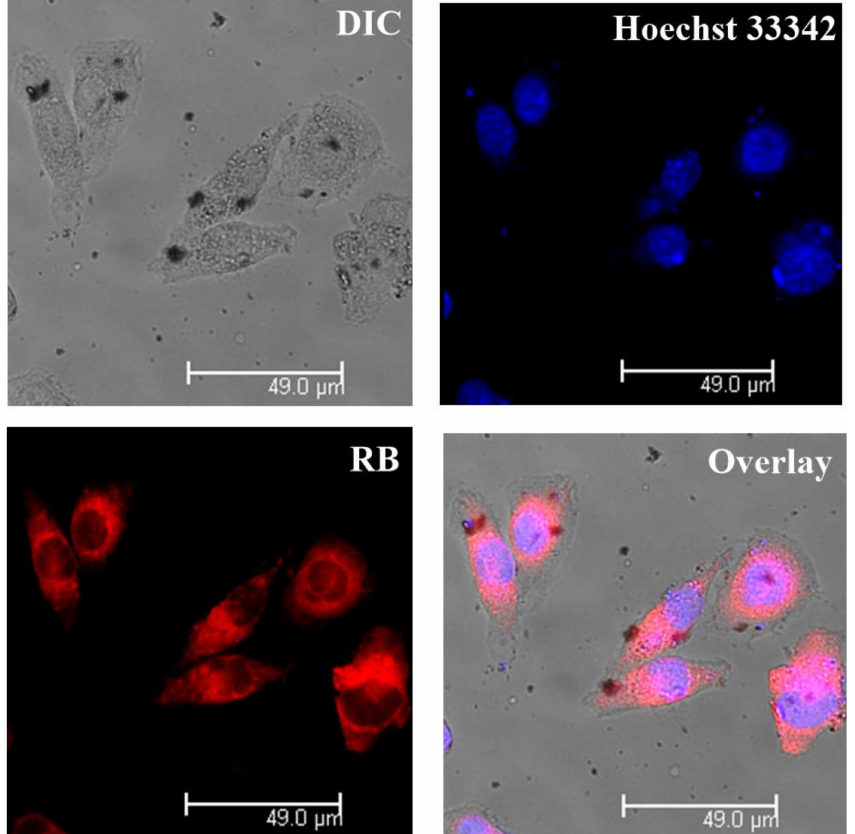
Figure 6. Confocal laser scanning microscopy (CLSM) images of Bel-7402 cells incubated by RB-labelled poly( L -lysine) 50 - block -poly( L -leucine) 15